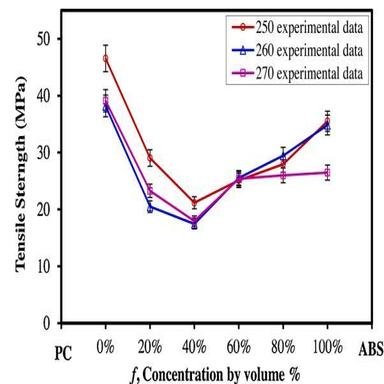
Tensile strength of PC/ABS material compositions printed at different temperatures.